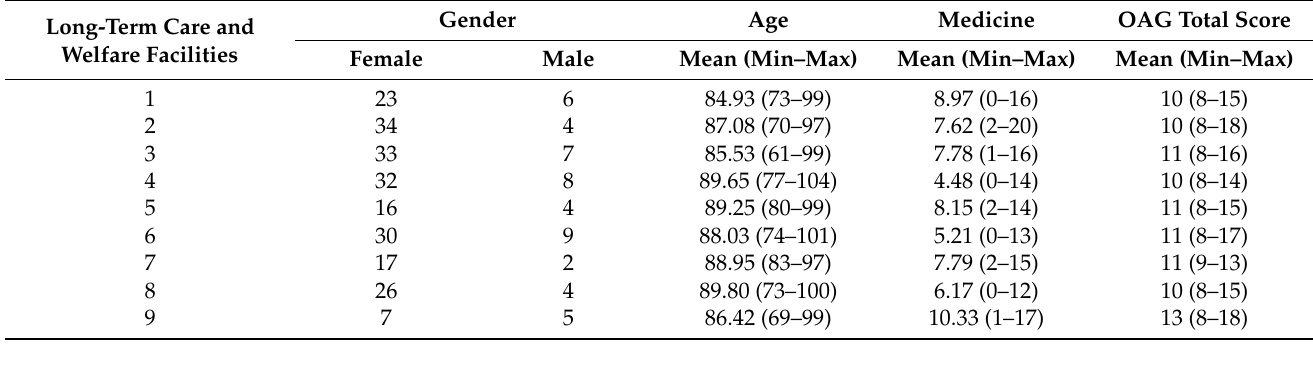
Table 1. Subject information at baseline.